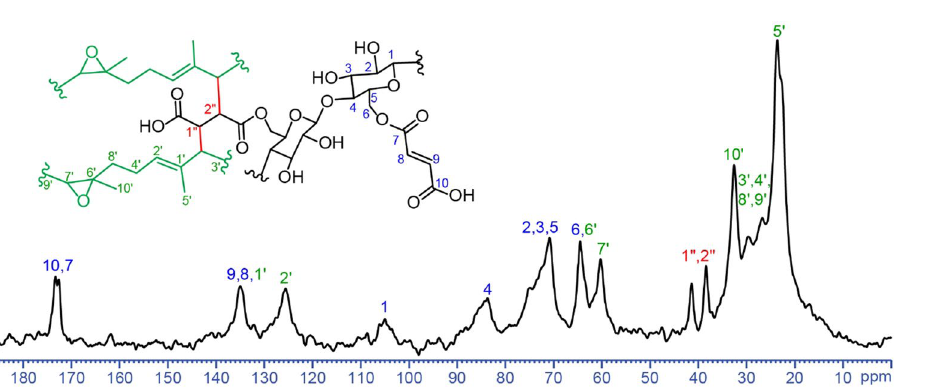
Figure 7. 13 C cross polarization-magic angle spinning (CP-MAS) NMR spectrum of the ENR/M-CNC